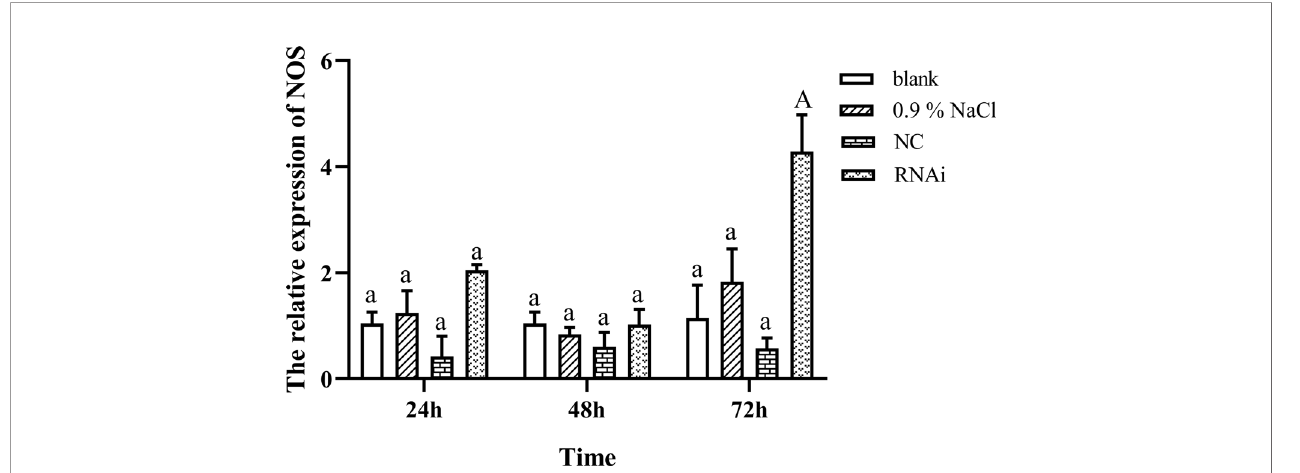
FIGURE 4 | NOS expression after knocking down FMRFamide precursor mRNA. Data were analyzed by two-way ANOVA followed by Dunnett ’ s post-hoc test. The capital letter indicates a highly signi fi cant difference ( p < 0.01); the same small letter indicates no signi fi cant difference ( p > 0.05). NOS, nitric oxide synthase.